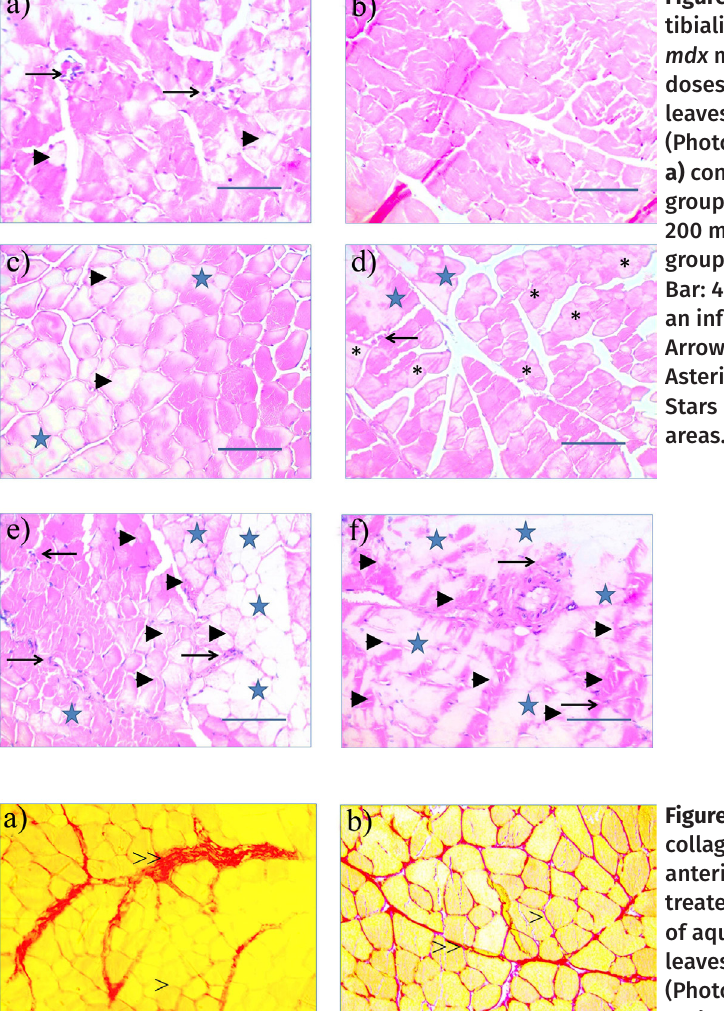
Figure 7. Distribution of collagen fibers in tibialis anterior muscle of mdx mice treated with different doses of aqueous extract from leaves of Miconia ferruginata (Photomicrography, Picrosirius Red staining). a) control group;